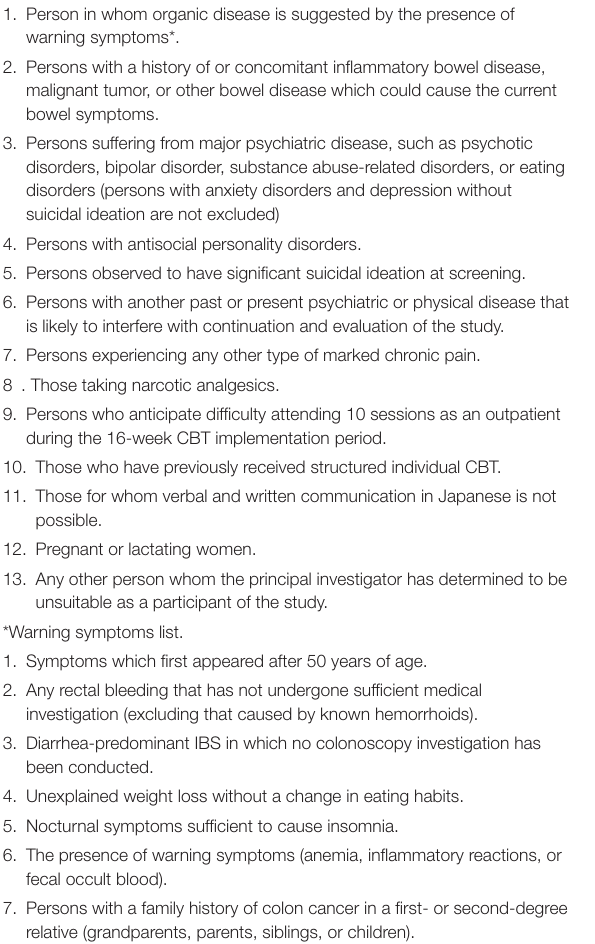
TABLE 1 | Eligibility criteria and warning symptoms